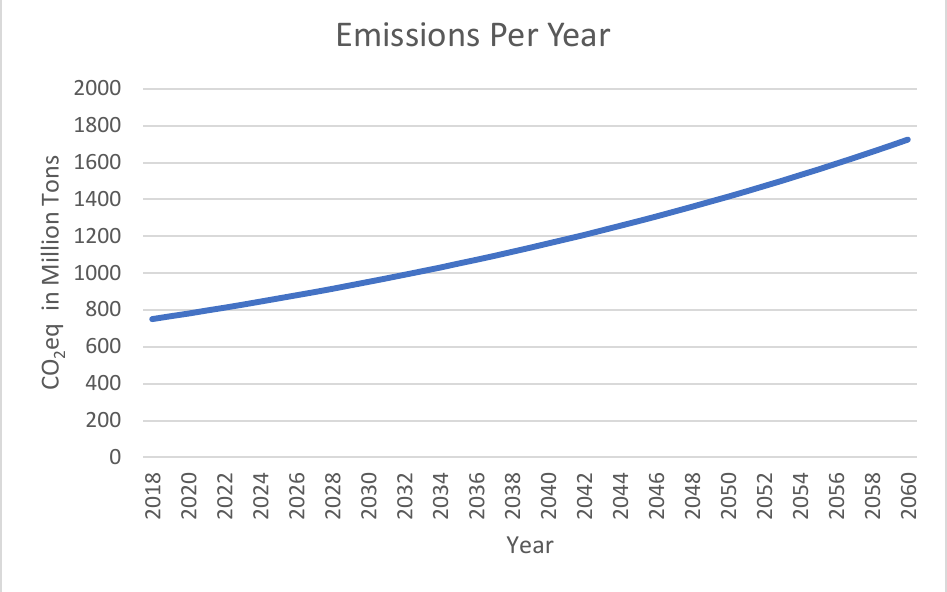
Figure 7. GHG emissions forecast under a business-as-usual (BAU) scenario.